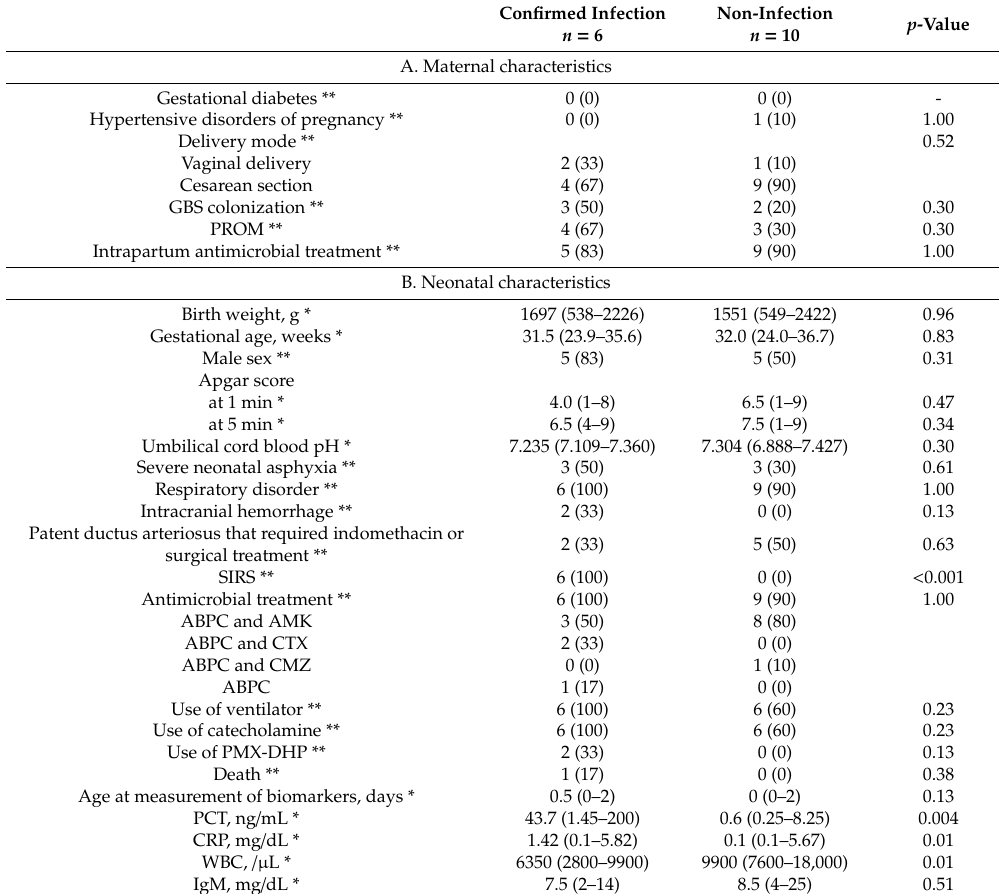
Table 1. Distribution of clinical characteristics of preterm infants.